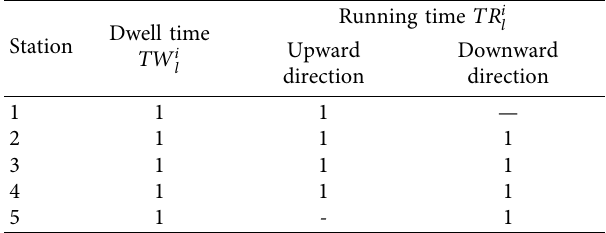
Table 9: Dwell time and running time of the trains in the numerical case.